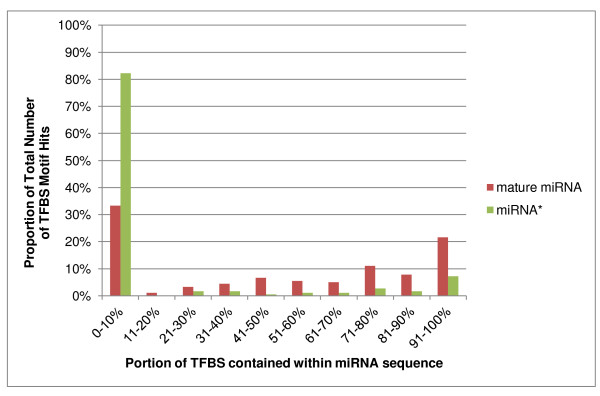
TFBS motifs tend to overlap with mature miRNA sequences. For all human pre-miRs, each TFBS motif hit was tabulated in terms of how fully it overlapped with the mature miRNA sequence or miRNA* sequence. 100% means that a TFBS is completely contained inside the miRNA or miRNA* mature sequence.